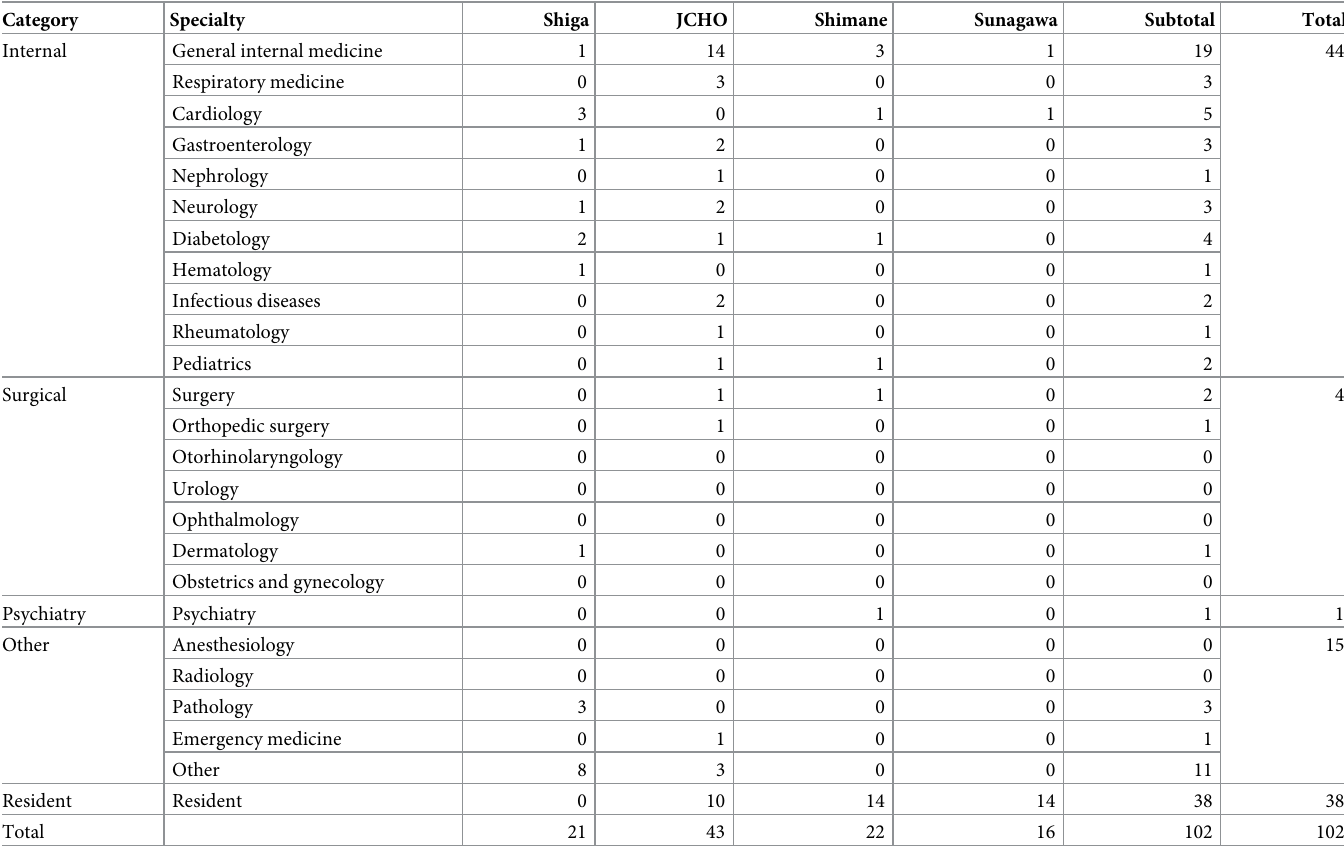
Table 2. Participant profiles by specialty.